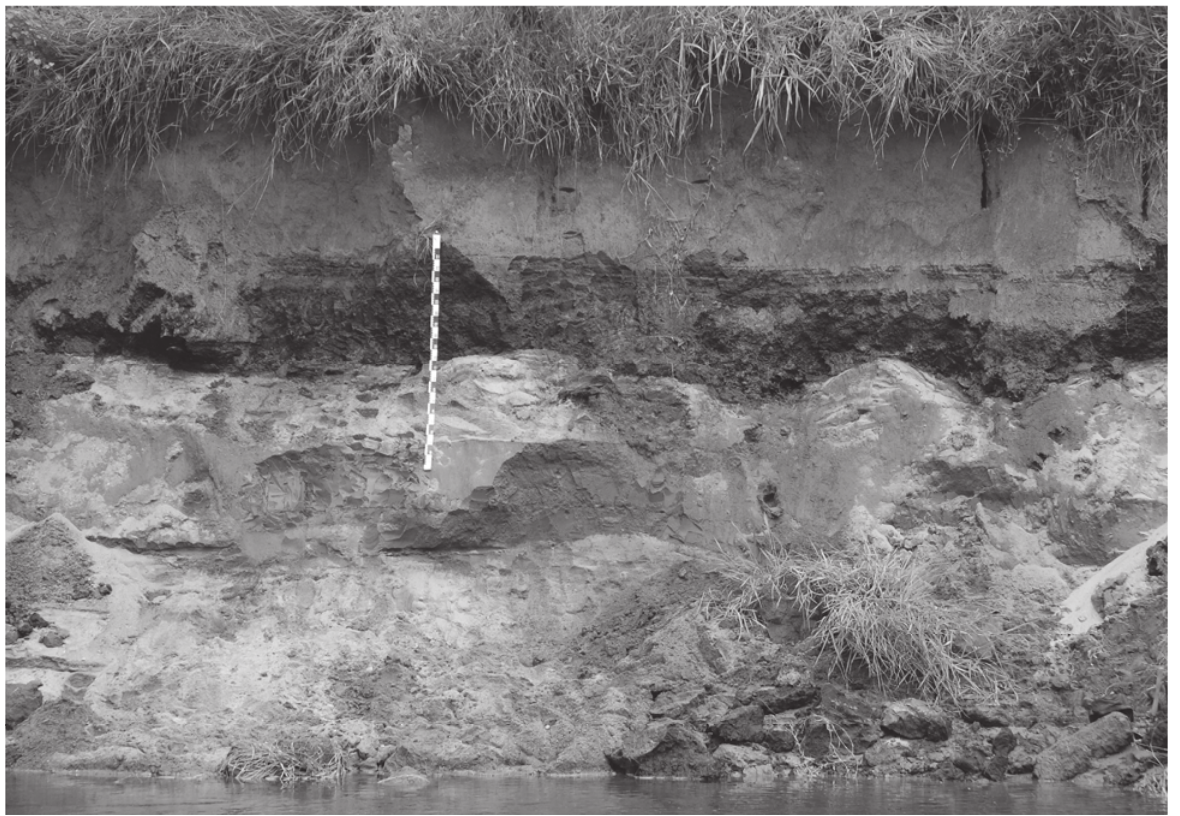
Figure 7 - Up to 1.5 m thick buried peat deposits in fl oodplain sediments along Rio